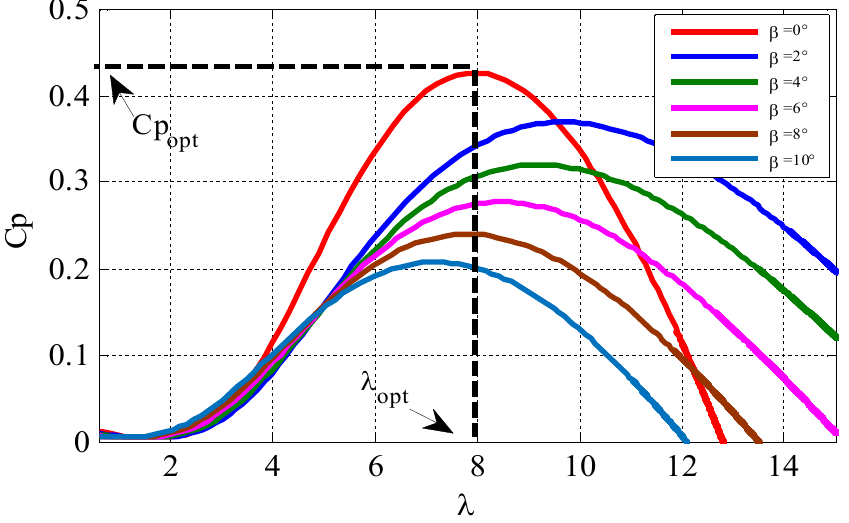
Figure 3. Characteristics Cp- λ for various values of the pitch angle.